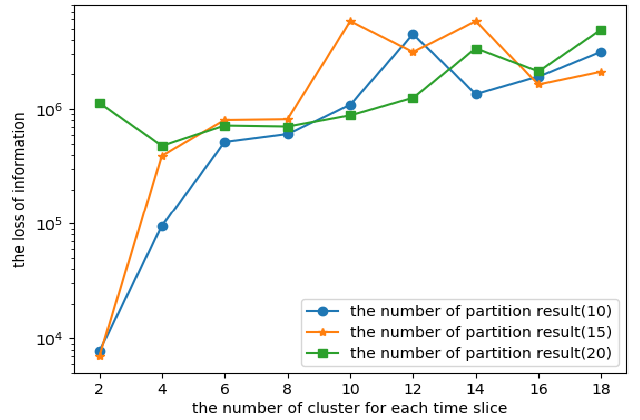
Figure 9. The loss of information (T-drive